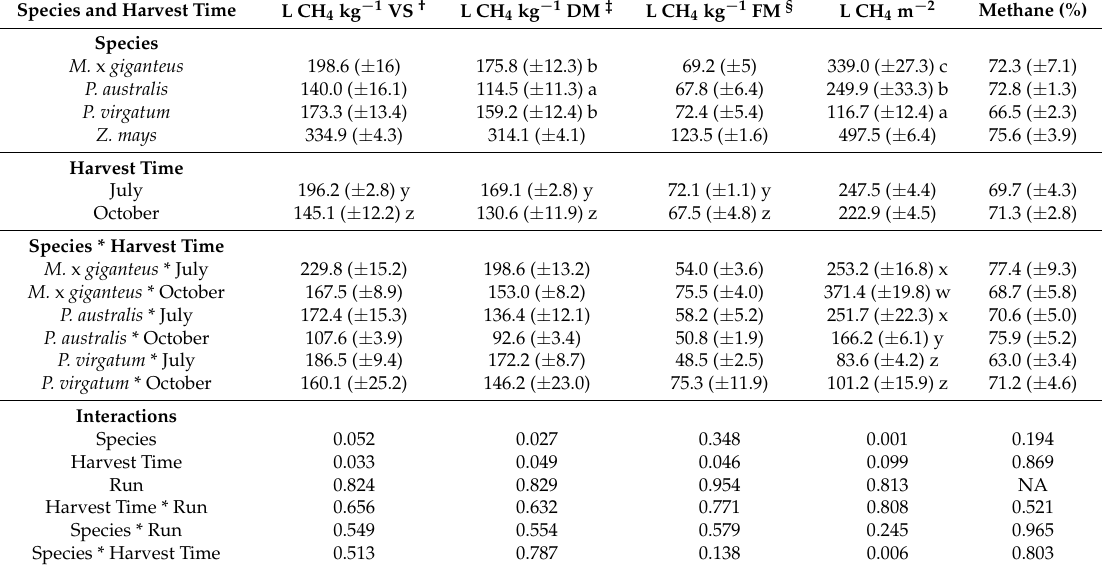
Table 5. Mean methane yields from mesophilic bench-top reactors for Miscanthus x giganteus ‘Nagara’, Panicum virgatum , and Phragmites australis when harvested in July or October ( n = 3). Means for corn silage ( Zea mays ) displayed ( n = 9), but not included in the two-way ANOVA. Means followed by the same letter in each column were not significantly different according to Tukey’s range test ( p > 0.05). Methane yield presented on volatile solids, dry matter, and fresh matter basis for ease of use by biogas facility